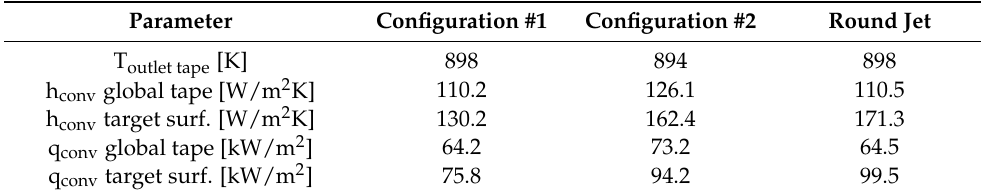
Table 9. Main thermal parameters obtained in the different